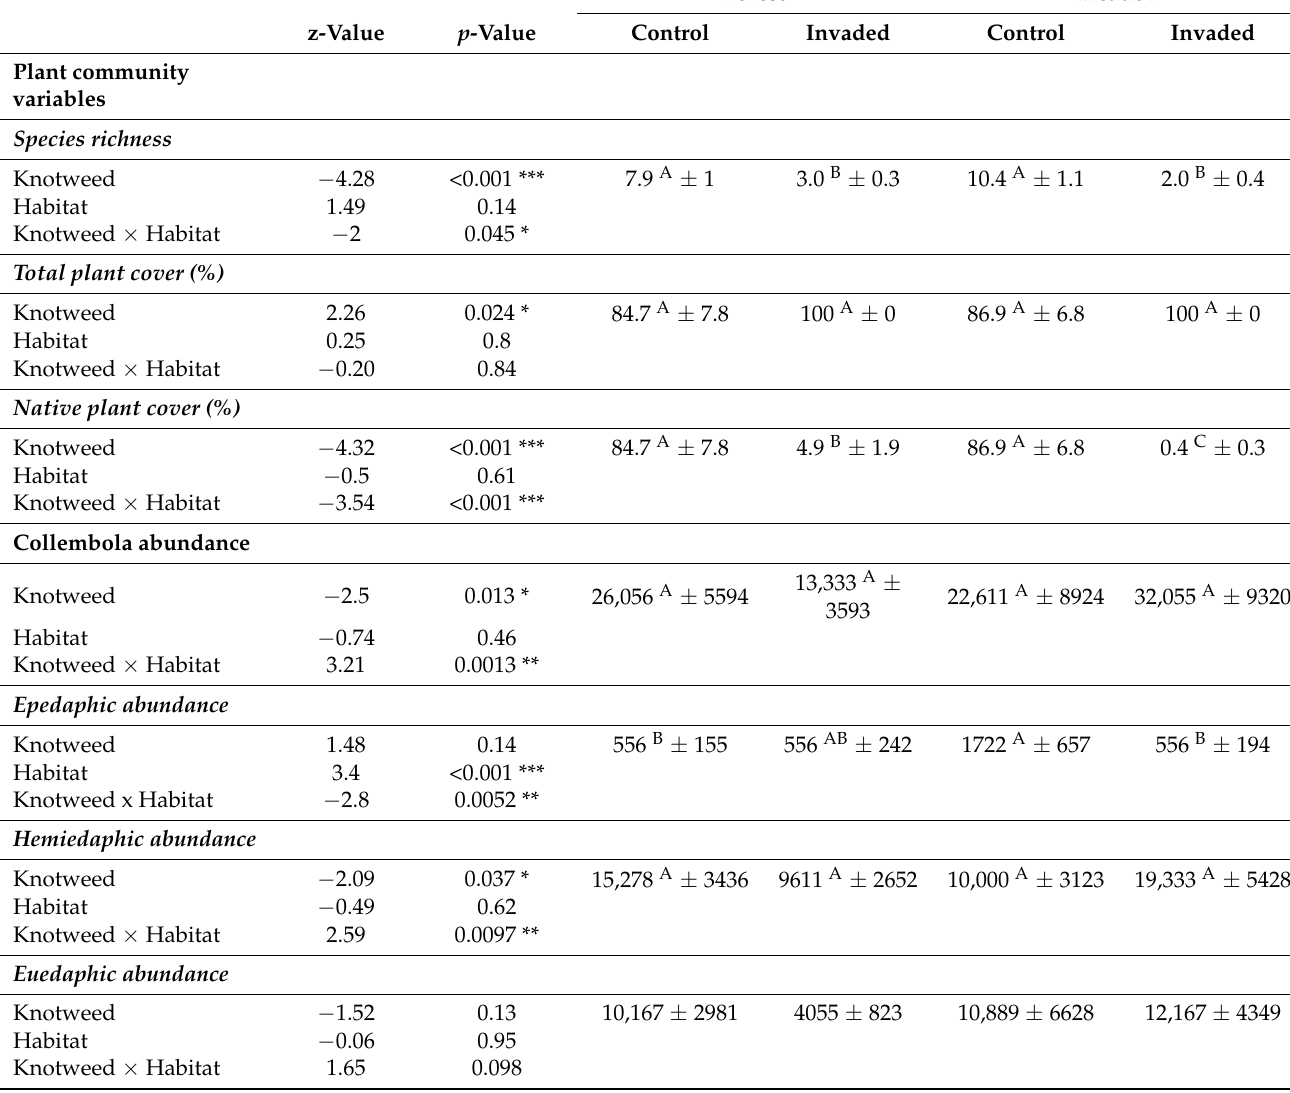
Table 2. Effects of the factors “Knotweed” with two levels: presence or absence, “Habitat” with two levels: forest or meadow and their interaction on plant community variables and Collembola variables (ind.m − 2 ). Values are means ± standard errors. z-values and associated p -values were obtained from GLMM with a binomial negative distribution (zero-inflated models) for Collembola variables and with a gamma distribution for plant community parameters. Two values in the same row with a different letter are significantly different according to Tukey post hoc tests. *, **, and *** denote statistical significance at p = 0.05, 0.01, and 0.001, respectively. When the p -values obtained from GLMM were not significant, the post hoc test results are not reported. Forest Meadow Control Invaded Control